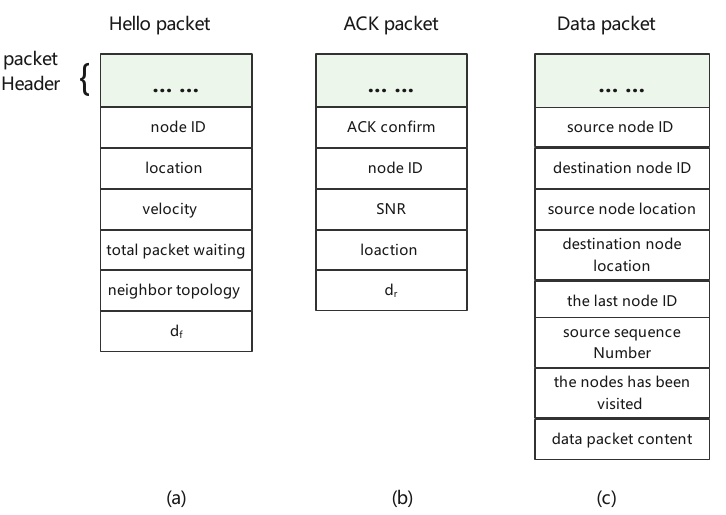
Figure 4. The format of the packets. ( a ) Hello packet. ( b ) ACK packet. ( c ) Data